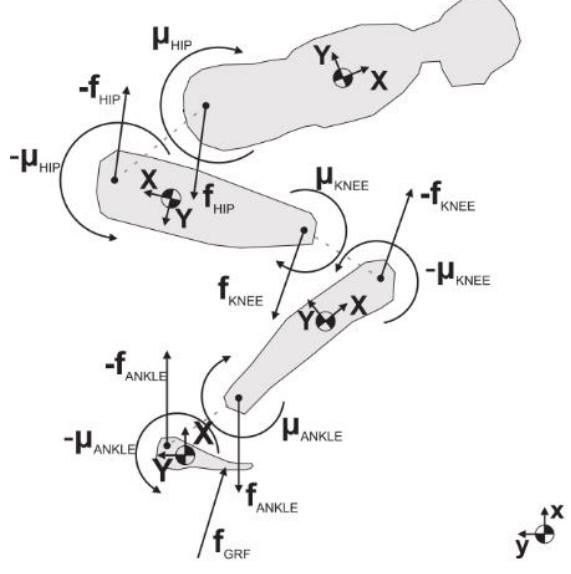
Figure 15. Free body diagram for each segment according to the model proposed by [72].